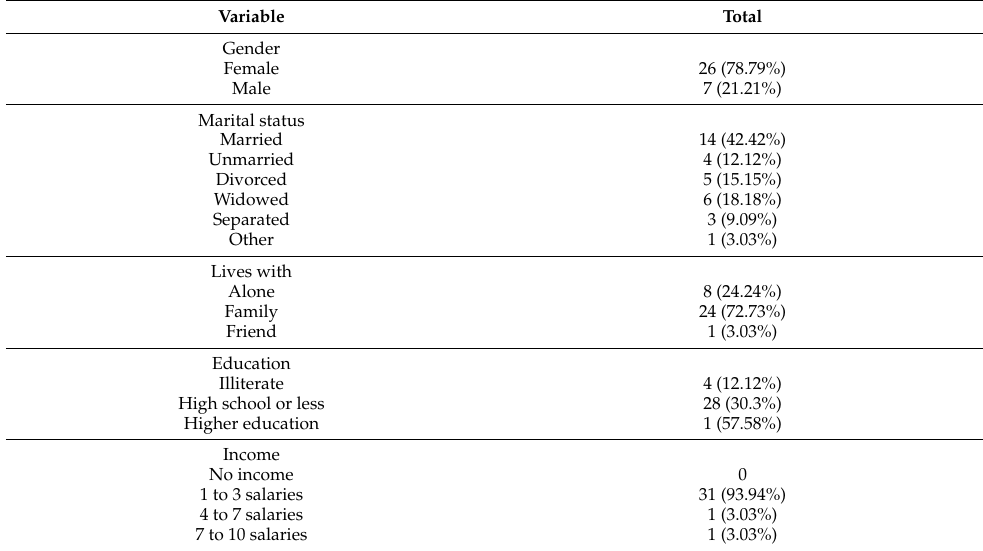
Table 1. Sociodemographic data of the sample expressed in absolute numbers